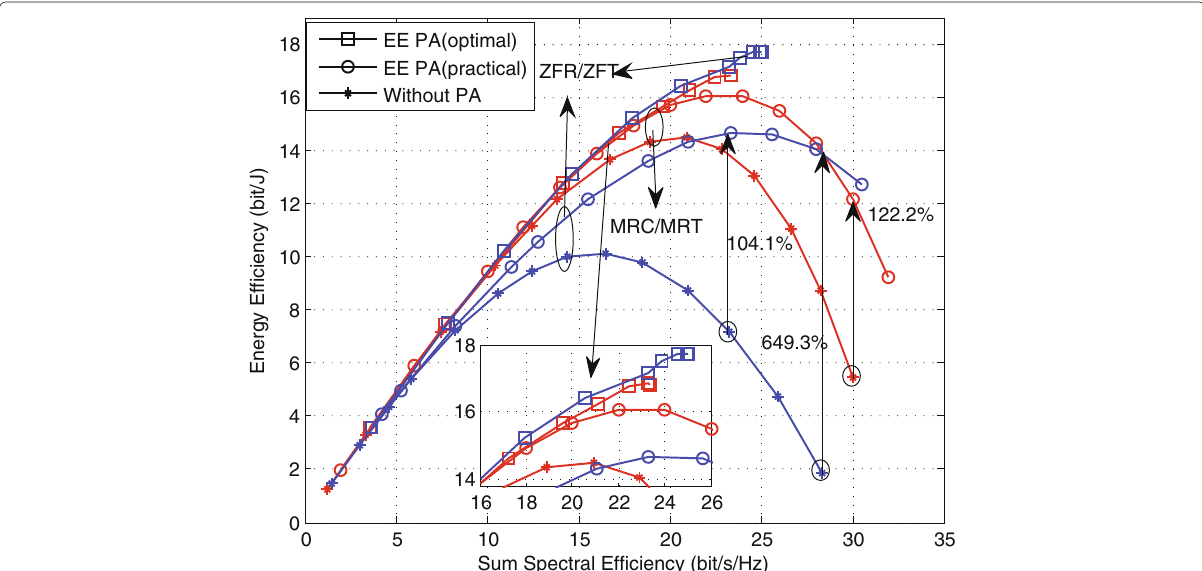
Fig. 5 Comparison of EE with and without EE PA versus SE where N = 200, p = q = 0.5, β LI = 10dB , P P = 0 dB, and E D = KE U which are set to make the EE maximization problem